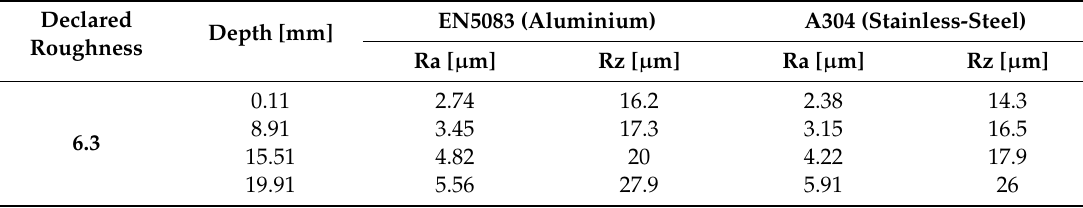
Table 5. Surface roughness of the samples measured by the Mitutoyo SJ400 at individual